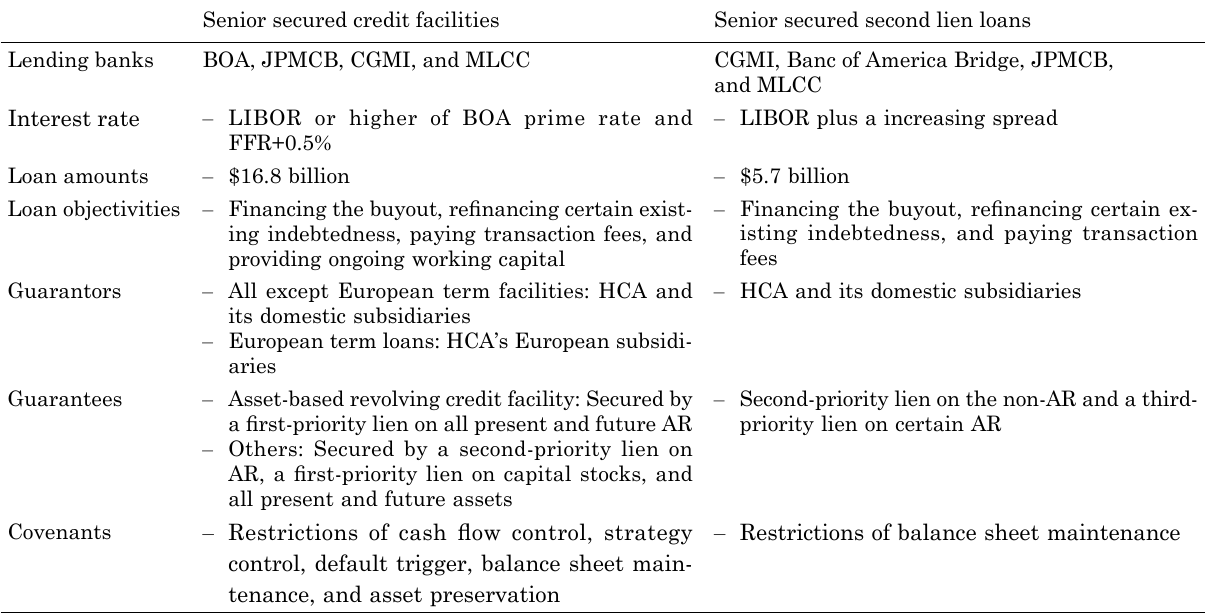
Table 4. The comparisons of two